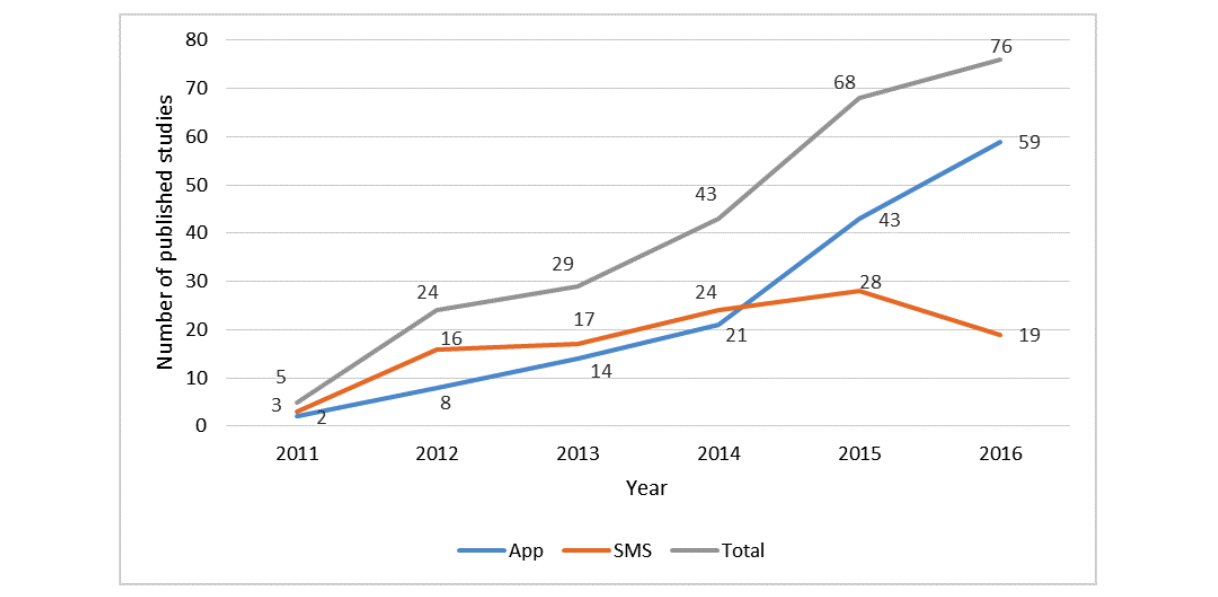
Figure 2. Trend of studies published from 2011 to 2016. Interventions combined with SMS and App were counted twice in each